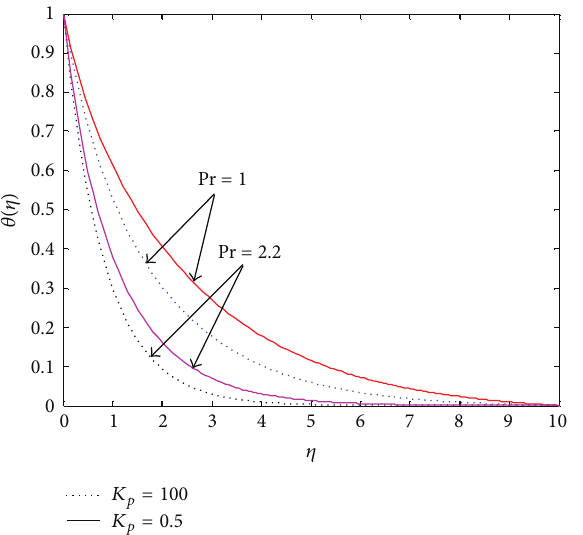
Figure 6: Temperature distribution for 𝑆 and 𝐾 𝑝 .